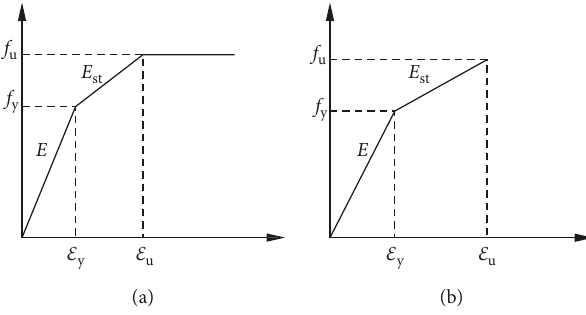
Figure 4: Constitutive model of materials. (a) Constitutive model of H-section steel. (b) Constitutive model of the bolt.